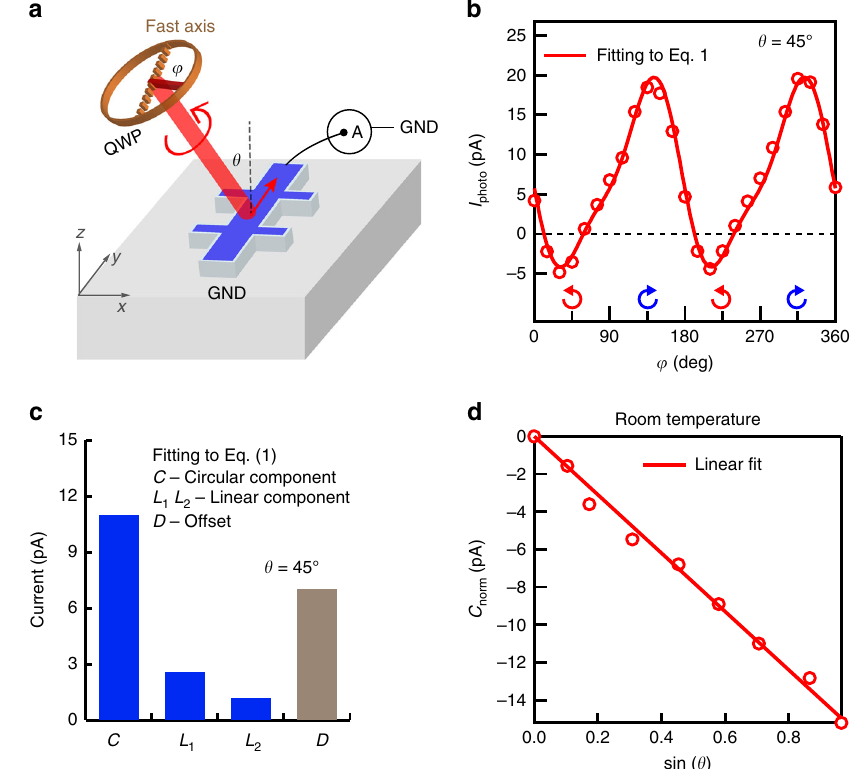
Fig. 1 Polarization-dependent photocurrent at room temperature. a Schematic of the excitation and measurement of photocurrent with obliquely incident excitation (incidence angle θ ) in the x - z plane. A quarter wave-plate (QWP) is used to tune the polarization of light (by tuning the angle φ between the fast axis and the linear polarization of light) and the photocurrent is measured along the y -axis. b Room temperature photocurrent along the y -axis in device A. At φ = 45°, the laser is left circularly polarized and the photocurrent is negative. At φ = 135°, the laser is right circularly polarized and the photocurrent is positive. The solid line is a fi t to Eq. (1). c The coef fi cients C , L 1 , L 2 and D as extracted from the fi t in b . The amplitude C of the HDPC dominates the polarization-dependent photocurrent. d Photocurrent measured at different incidence angles θ . The normalized amplitude C norm of the HDPC plotted as a function of sin( θ ) shows a linear